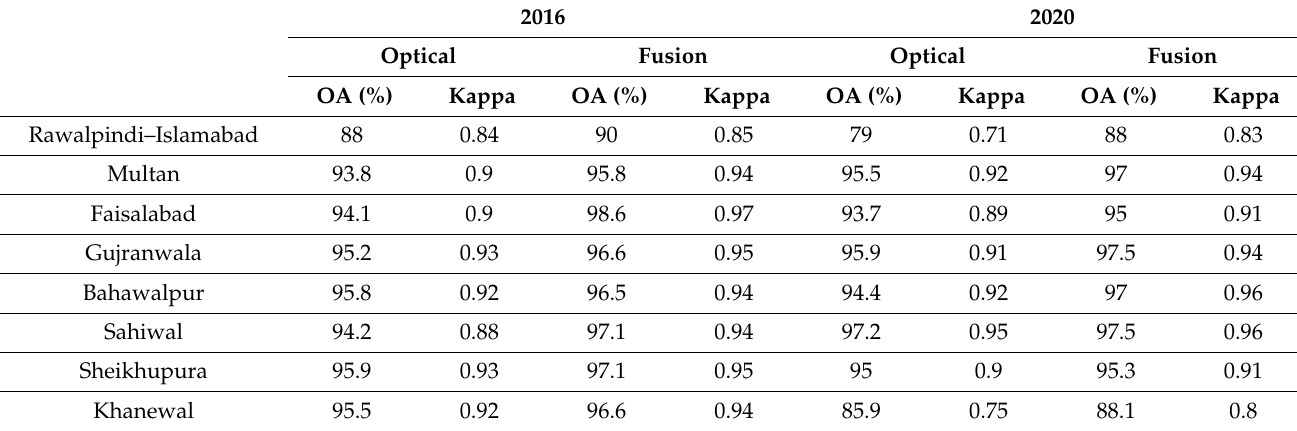
Table 7. Accuracy assessment of classified maps from optical and fused dataset: a comparative table.